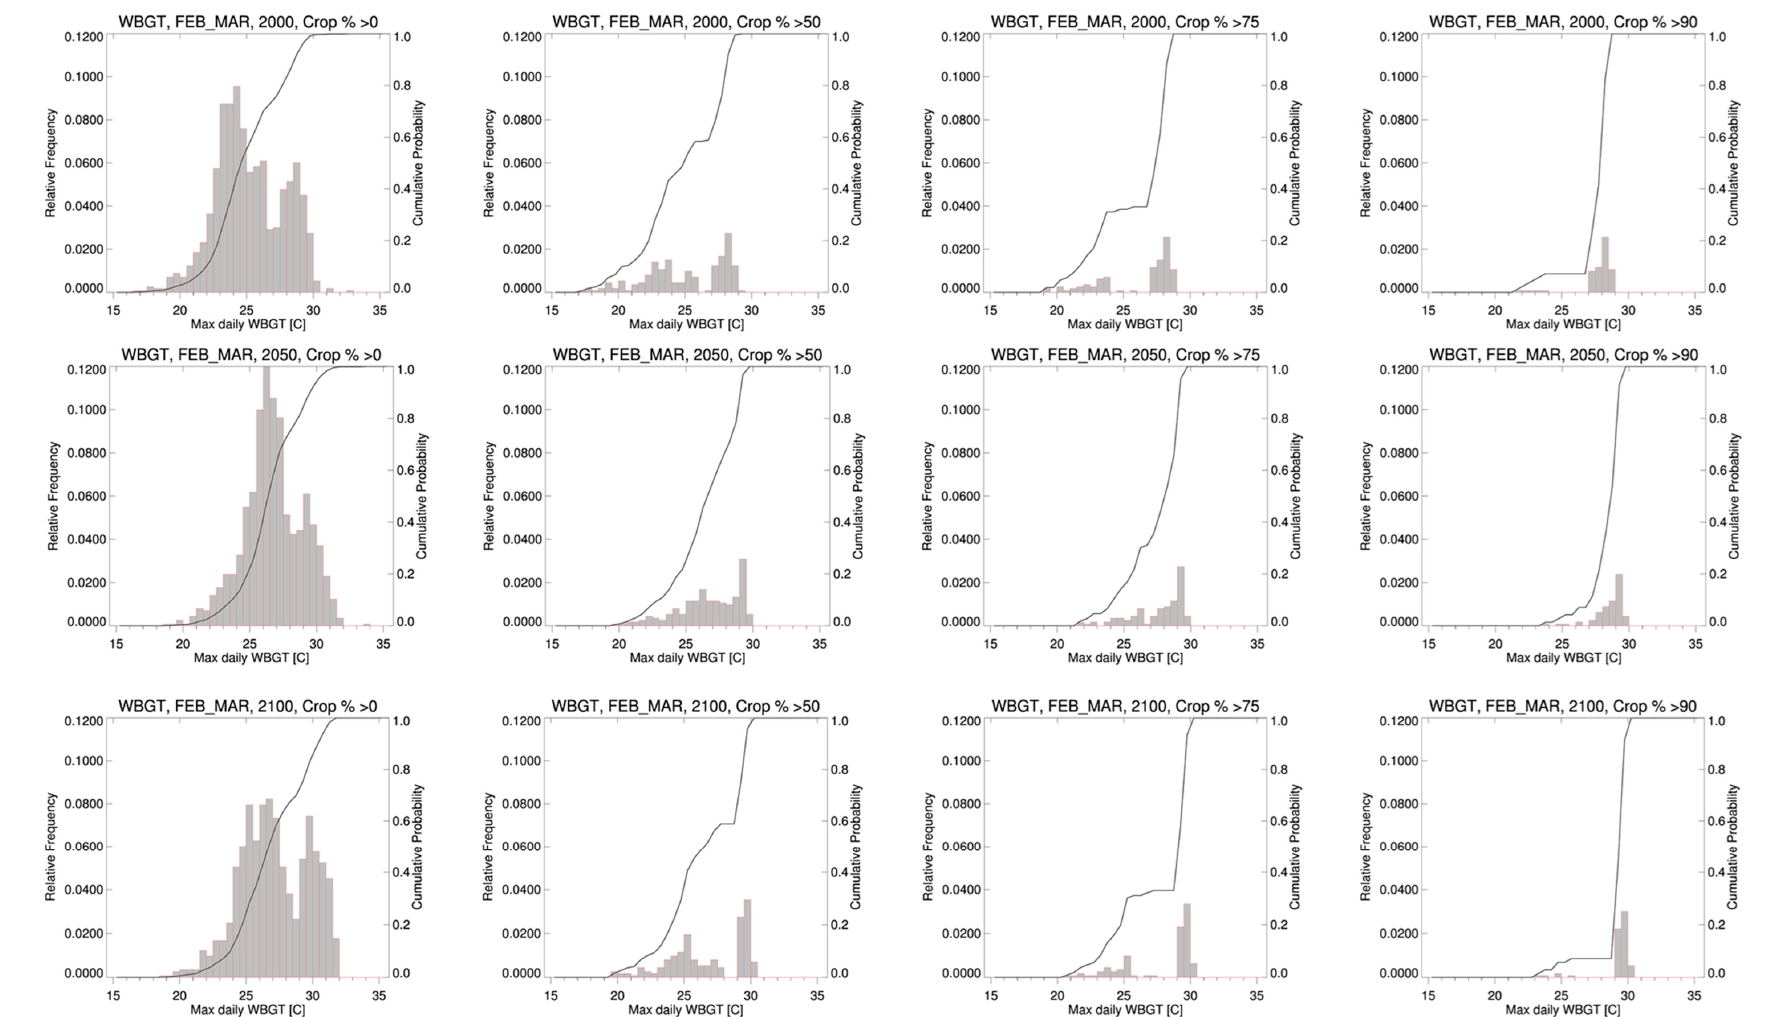
Figure 4. Frequency distribution and cumulative probability of WBGT and varying cropping intensities for February–March 2000, 2050, and 2100.